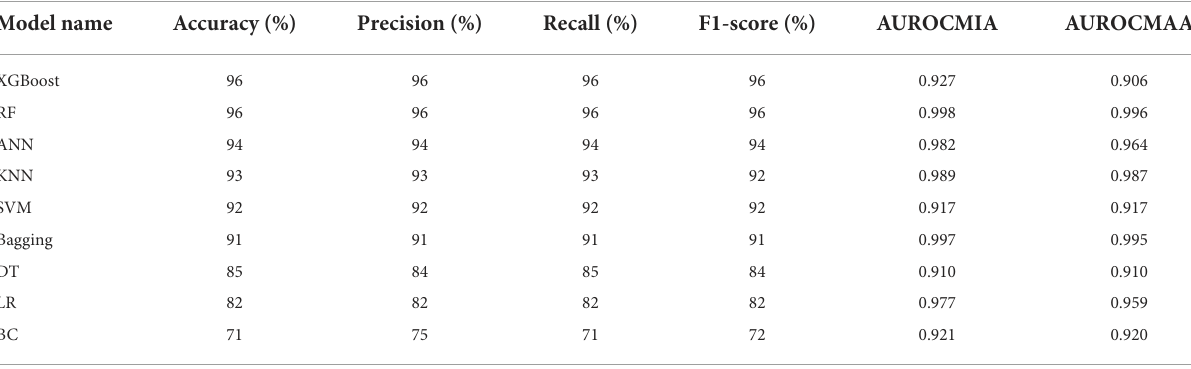
TABLE 3 Comparison of nine ML models using narratives